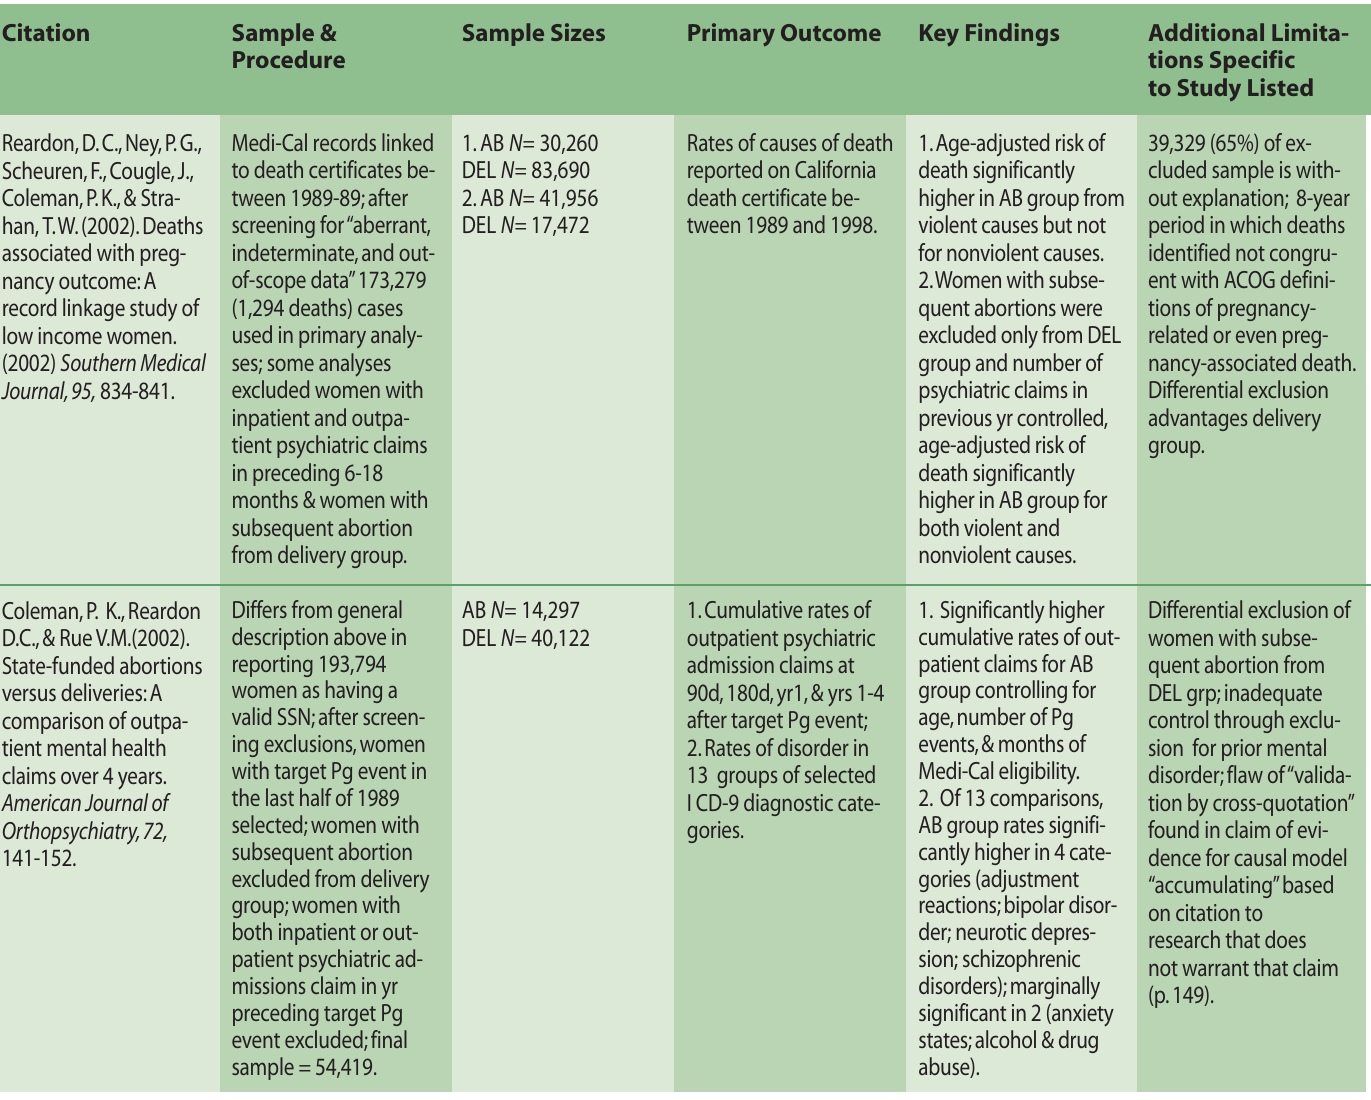
Table 1: Medical Records–Abortion vs.Comparison Groups U.S.STUDIES Medi-Cal Data